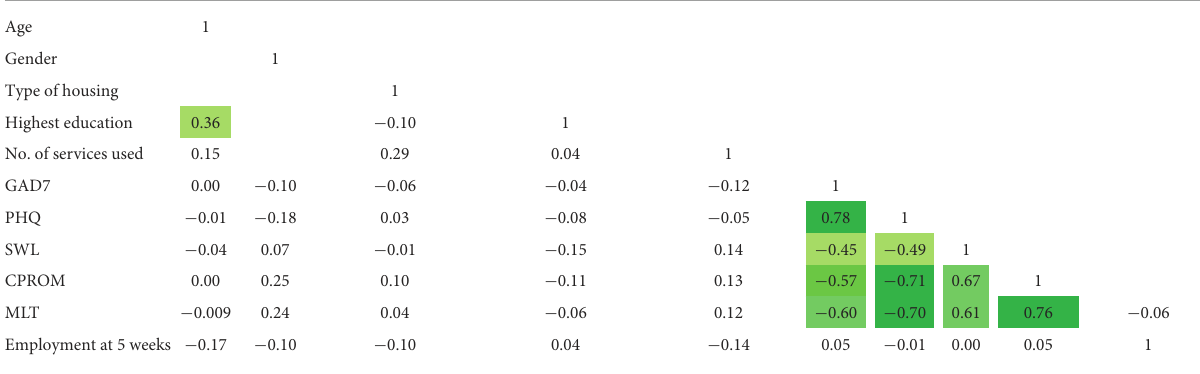
TABLE 4 Heatmap of